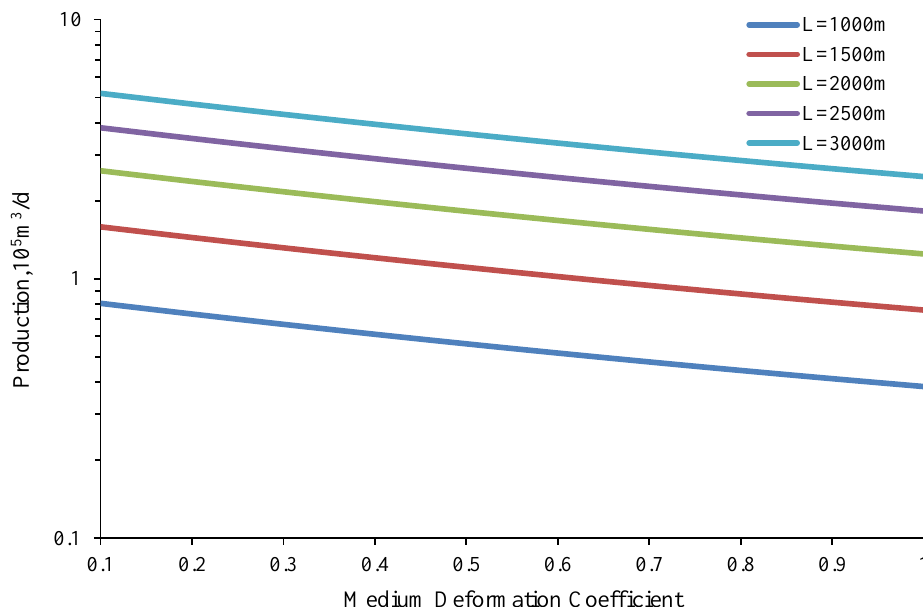
Figure 6—Effect of the medium deformation coefficient on production at different horizontal well length